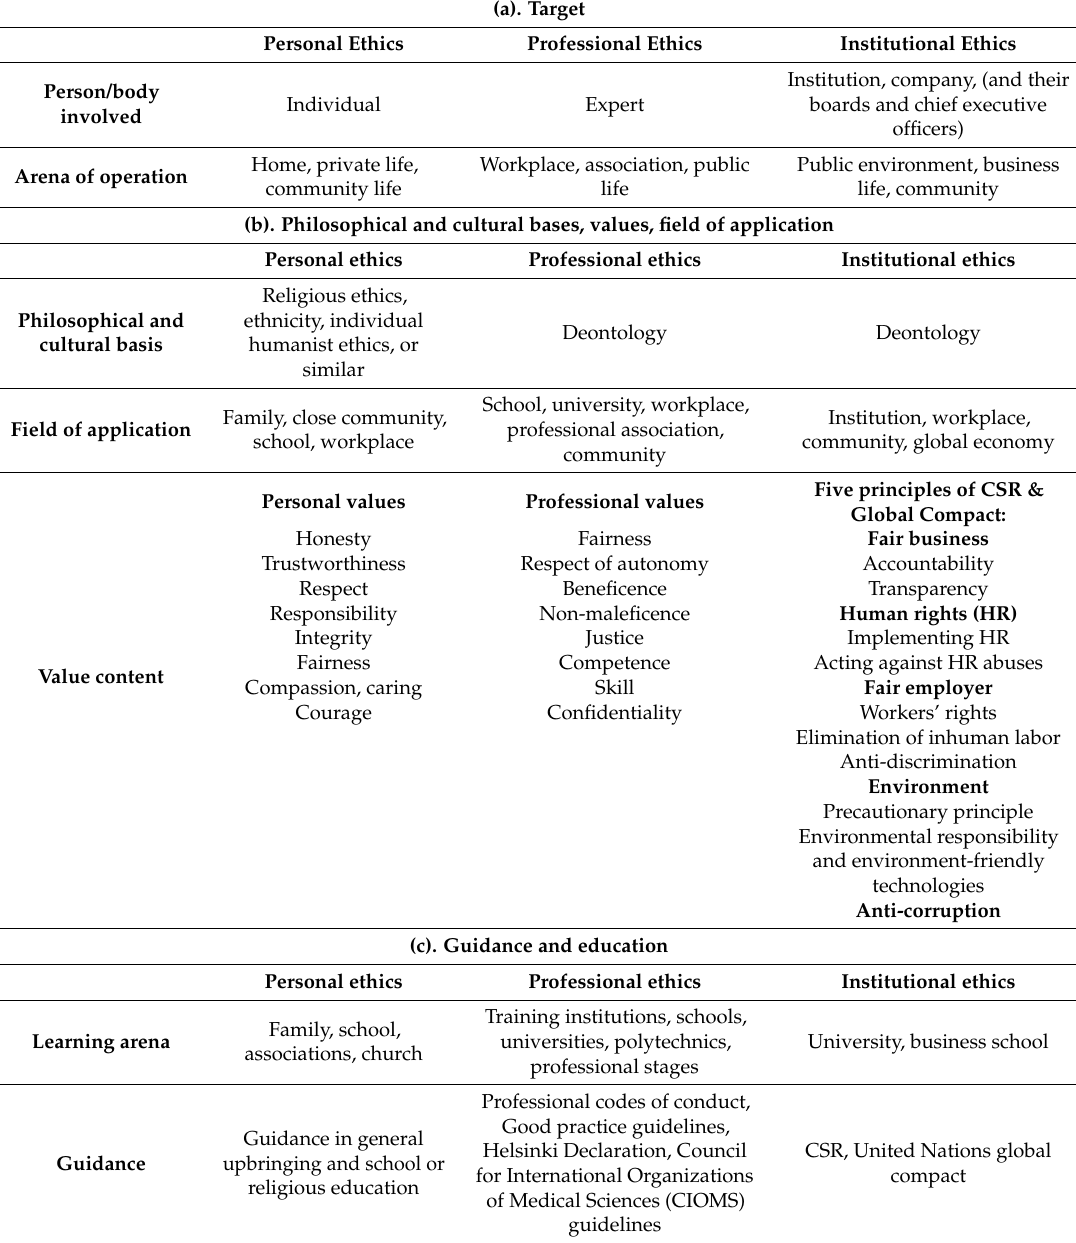
Table 1. Personal, Professional and Institutional